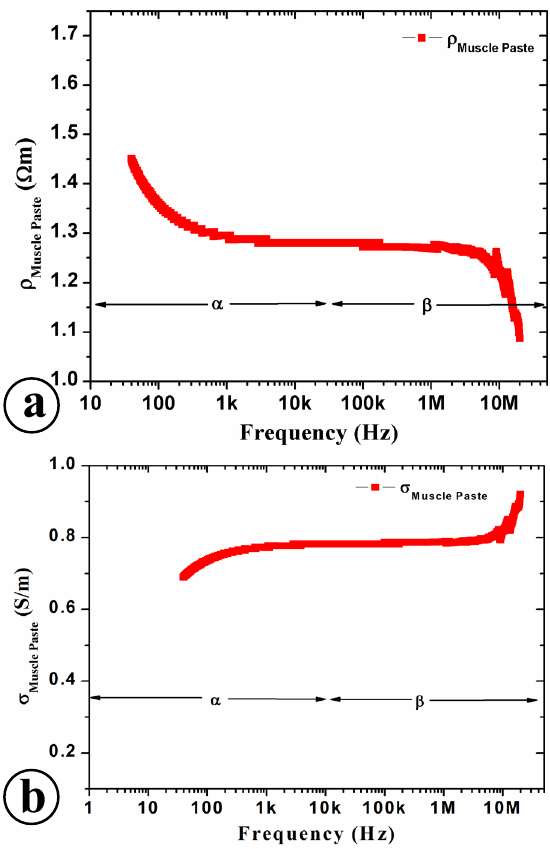
Figure-19: Variations of impedance parameters of chicken muscle tissue paste over frequency: (a) ρ Muscle Paste , (b) σ Muscle Paste .